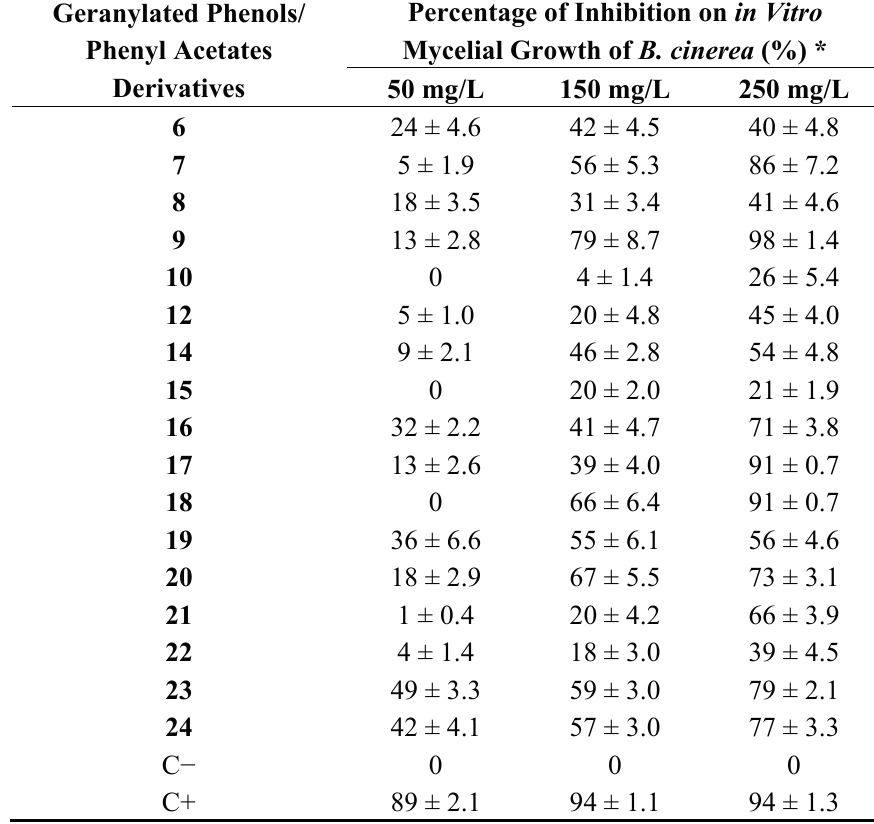
Table 2. Effect of geranylated phenol/phenyl acetate derivatives on in vitro mycelial growth of B. cinerea , measured as a percentage of inhibition